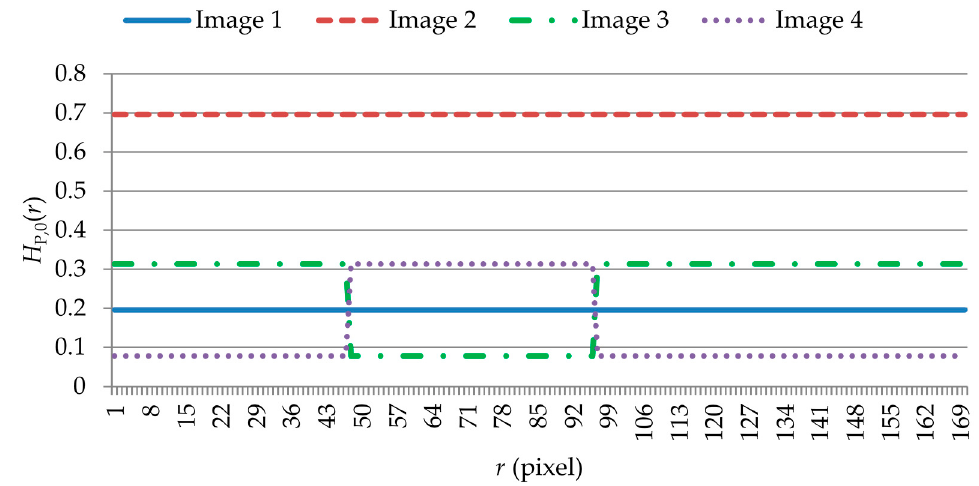
Figure 9. Hybrid projection features of texture ‐ less searching images.